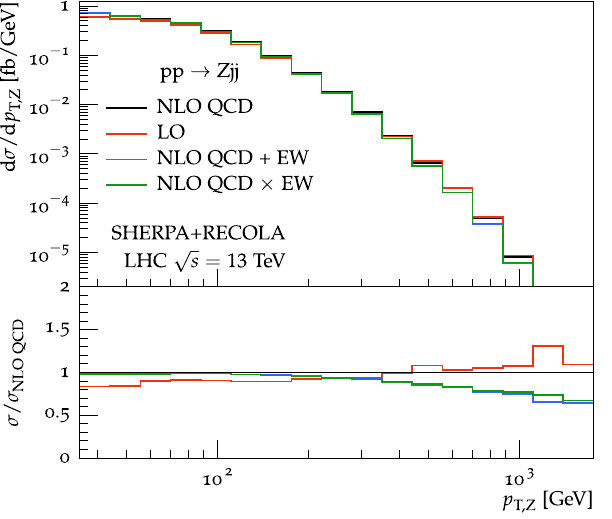
Fig. 12 Differential distributions at 13TeV for Z + jj production at the LHC. The left-hand plot shows the p T of the reconstructed Z boson for on-shell Z production and the right-hand plot the same observable